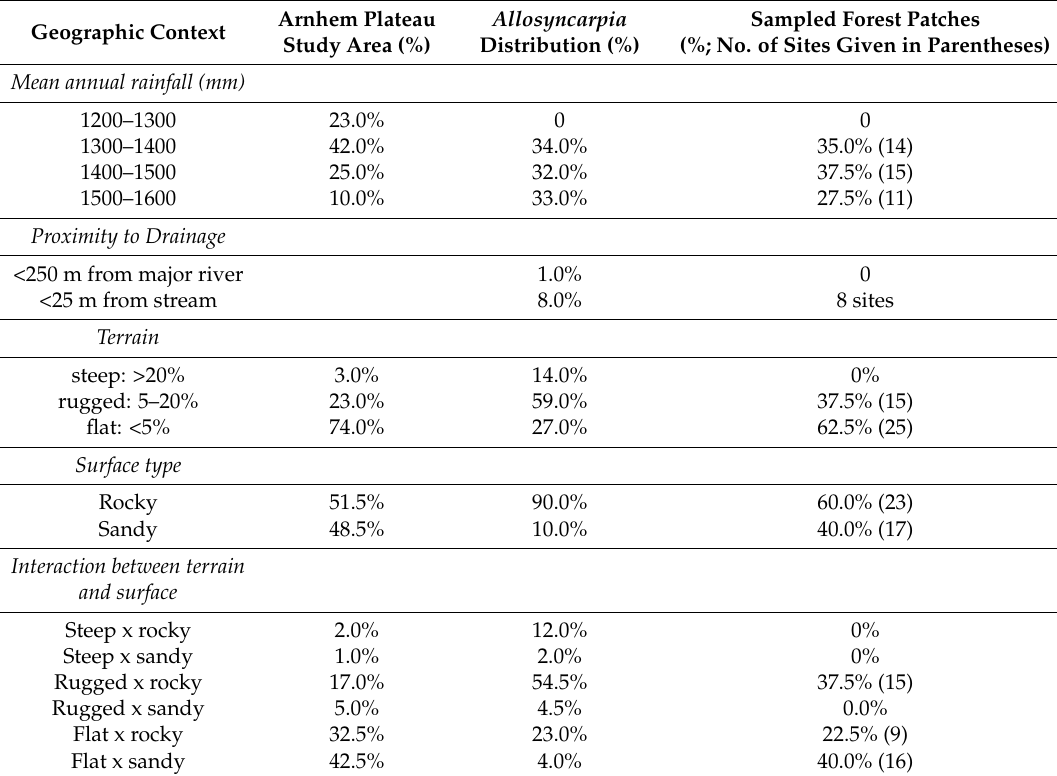
Table 2. Geographic affinities of the total distribution of Allosyncarpia on the Arnhem Plateau (29,600 km 2 ), and 40 Allosyncarpia forest patches sampled for the canopy cover assessment. Allosyncarpia Arnhem Plateau Sampled Forest Patches Geographic Context Study Area (%) Distribution (%) (%; No. of Sites Given in